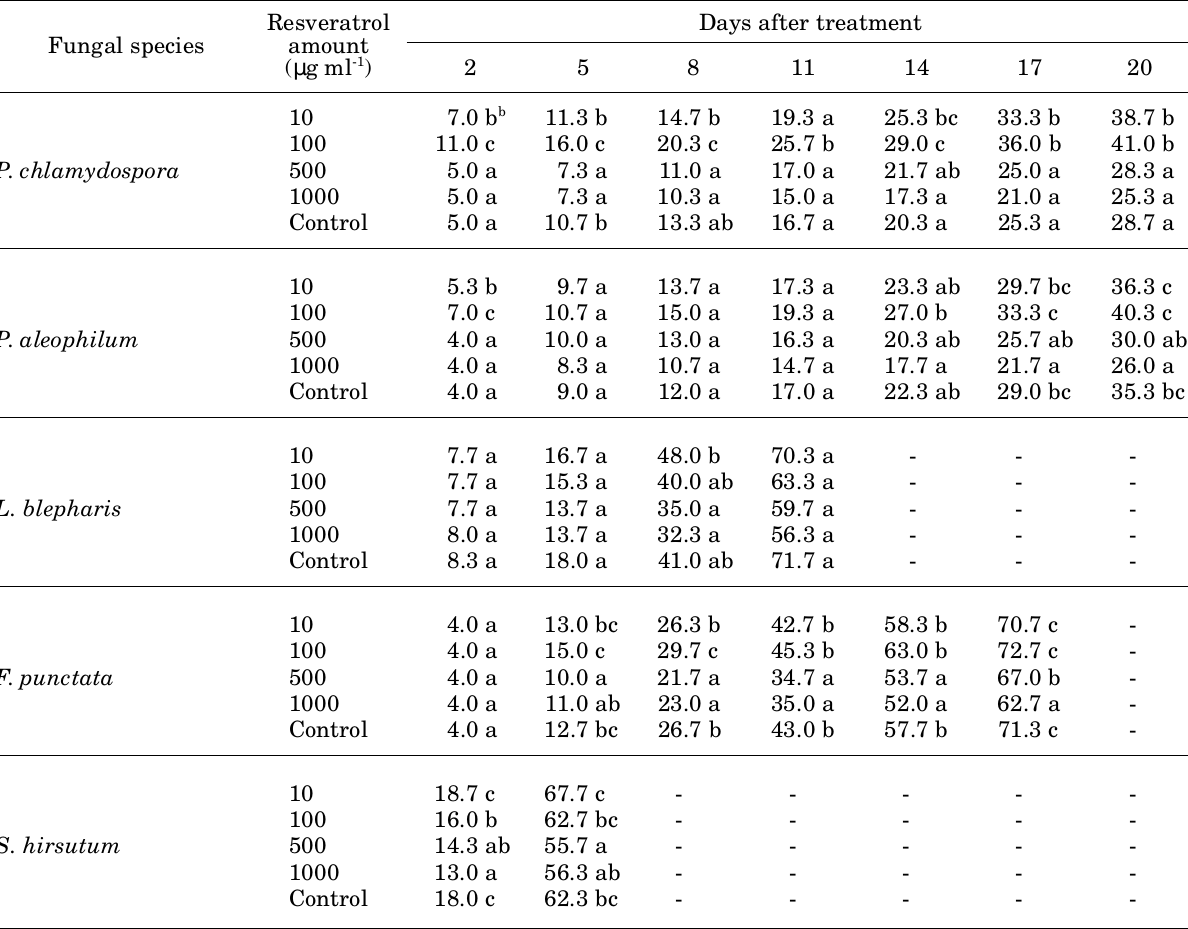
Table 1. Mycelial growth a of fungi with different amounts of resveratrol in the medium. Mycelial growth (mm) is expressed as colony